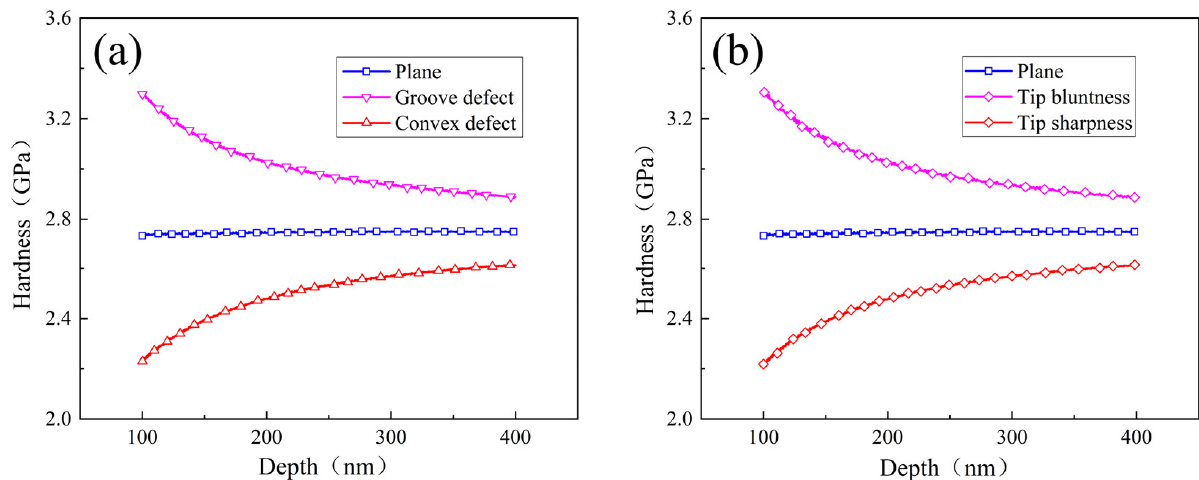
Figure 9. Hardness–depth curves. The measured hardness of plane is the true hardness of sample, and the true hardness is 2.75 GPa: ( a ) surface defect; ( b ) indenter tip irregularity.